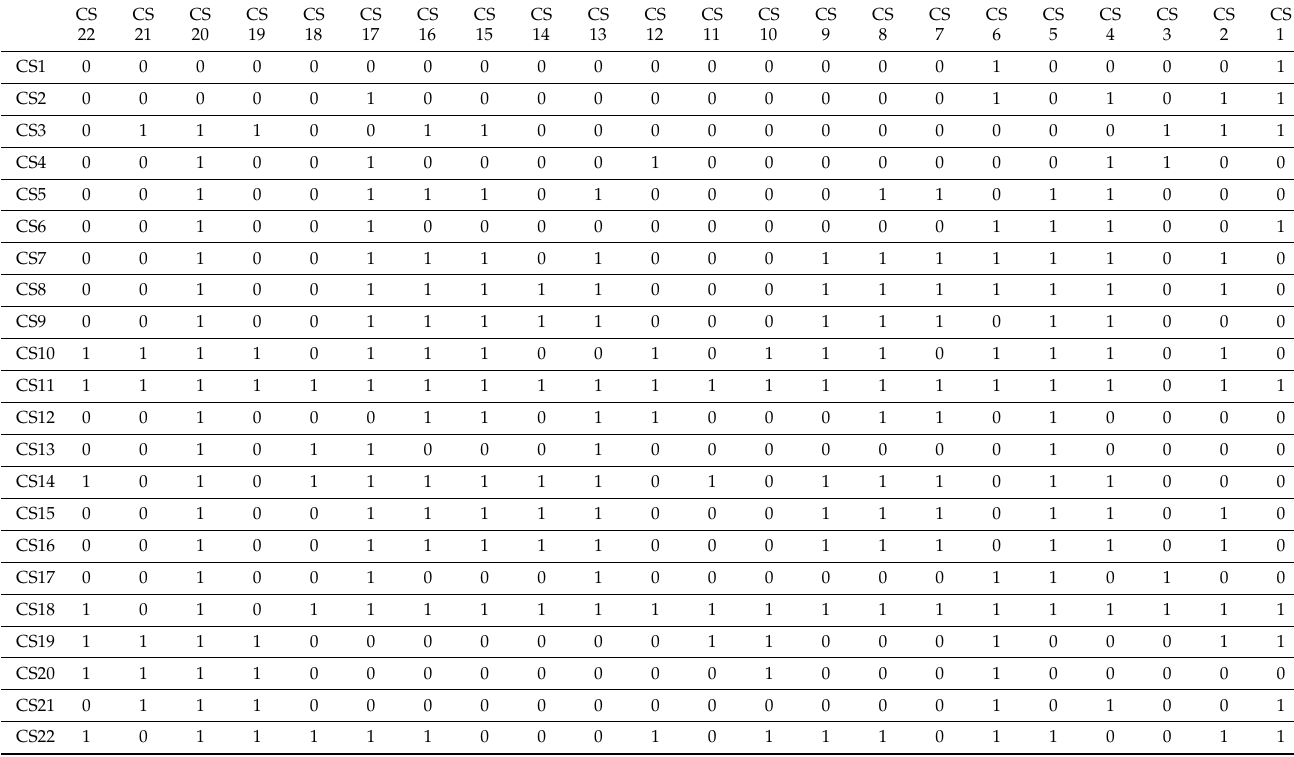
Table A2. Preliminary reachability